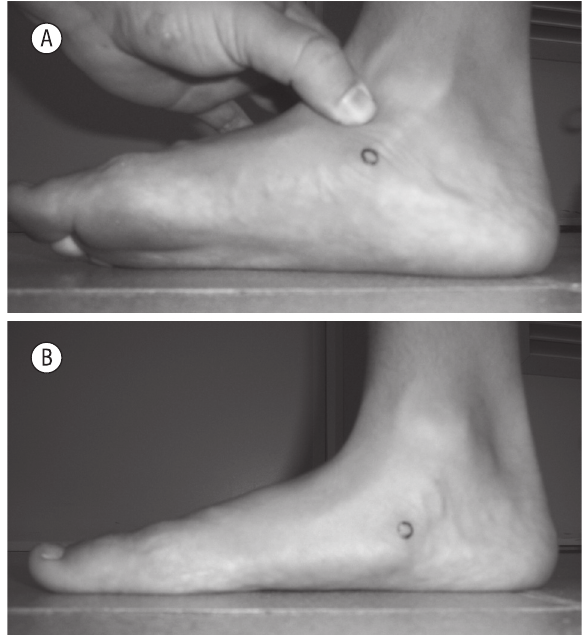
Figura 1 - Fotos ilustrativas do teste da queda do navicular. A) Subtalar em neutro. B) Altura da marcação du- rante o duplo